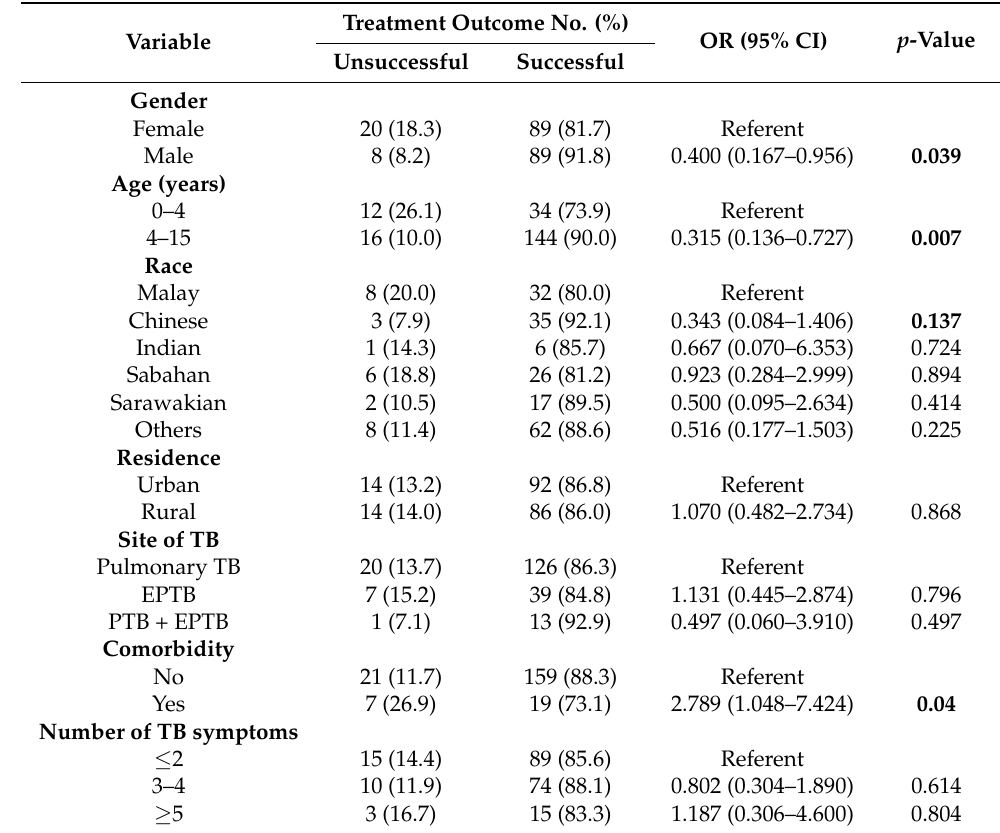
Table 3. Univariate analysis of predictors of unsuccessful treatment